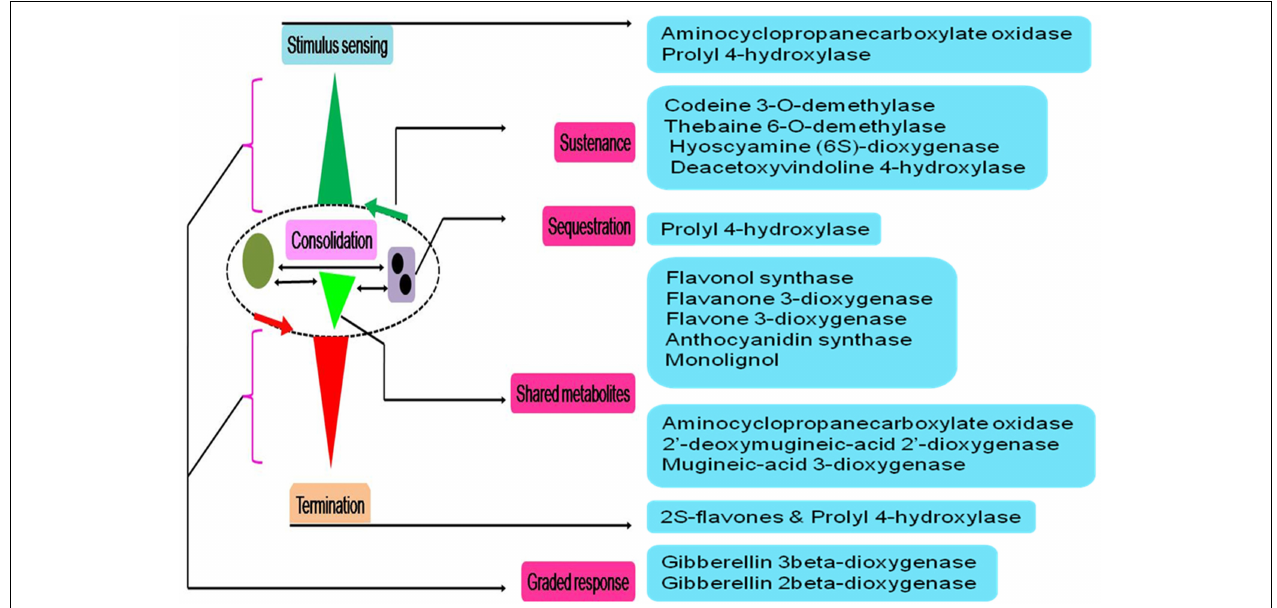
FIGURE 5 | Physiological model of 2-oxoglutarate dependent catalysis in influencing plant cell function. These enzymes have well established roles as catalysts and possess an asymmetric cellular distribution. Any model that spans an activity profile requires multiple interfacing points.